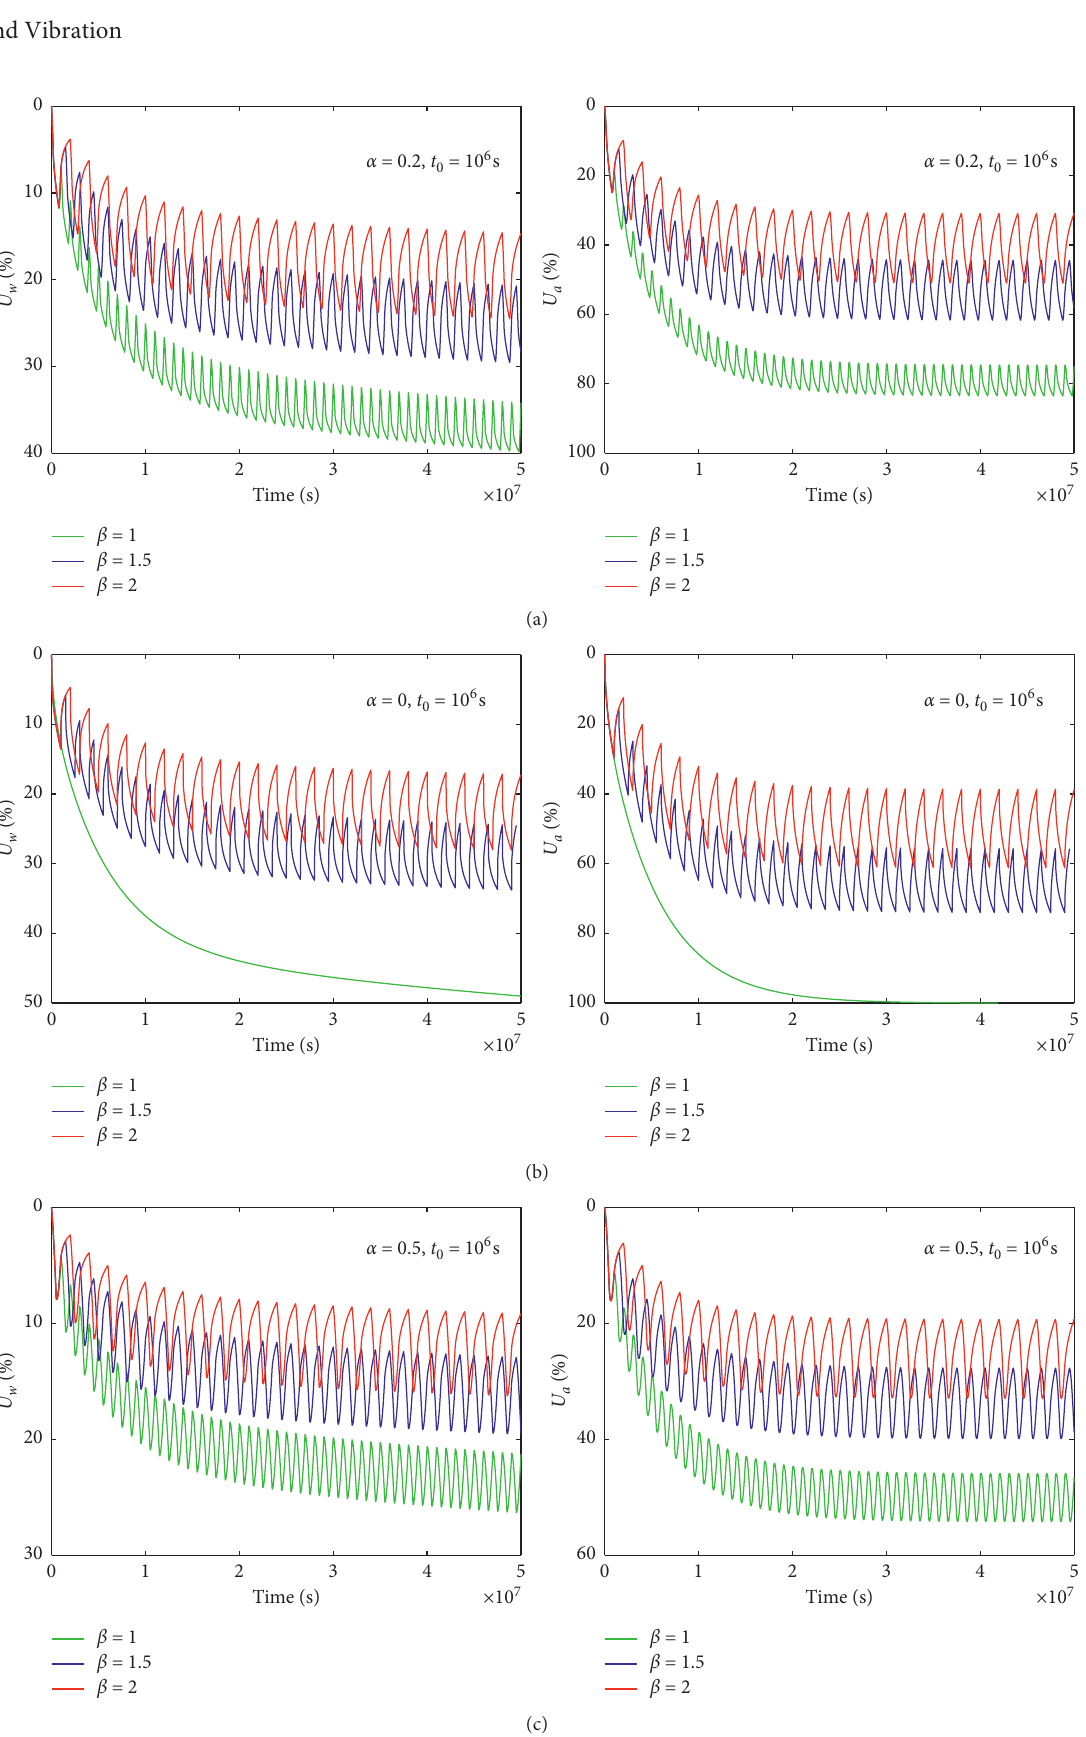
Figure 11: The effects of β on consolidation of unsaturated soils under various cyclic loadings: (a) trapezoidal cyclic loading; (b) rectangular cyclic loading; (c) triangular cyclic